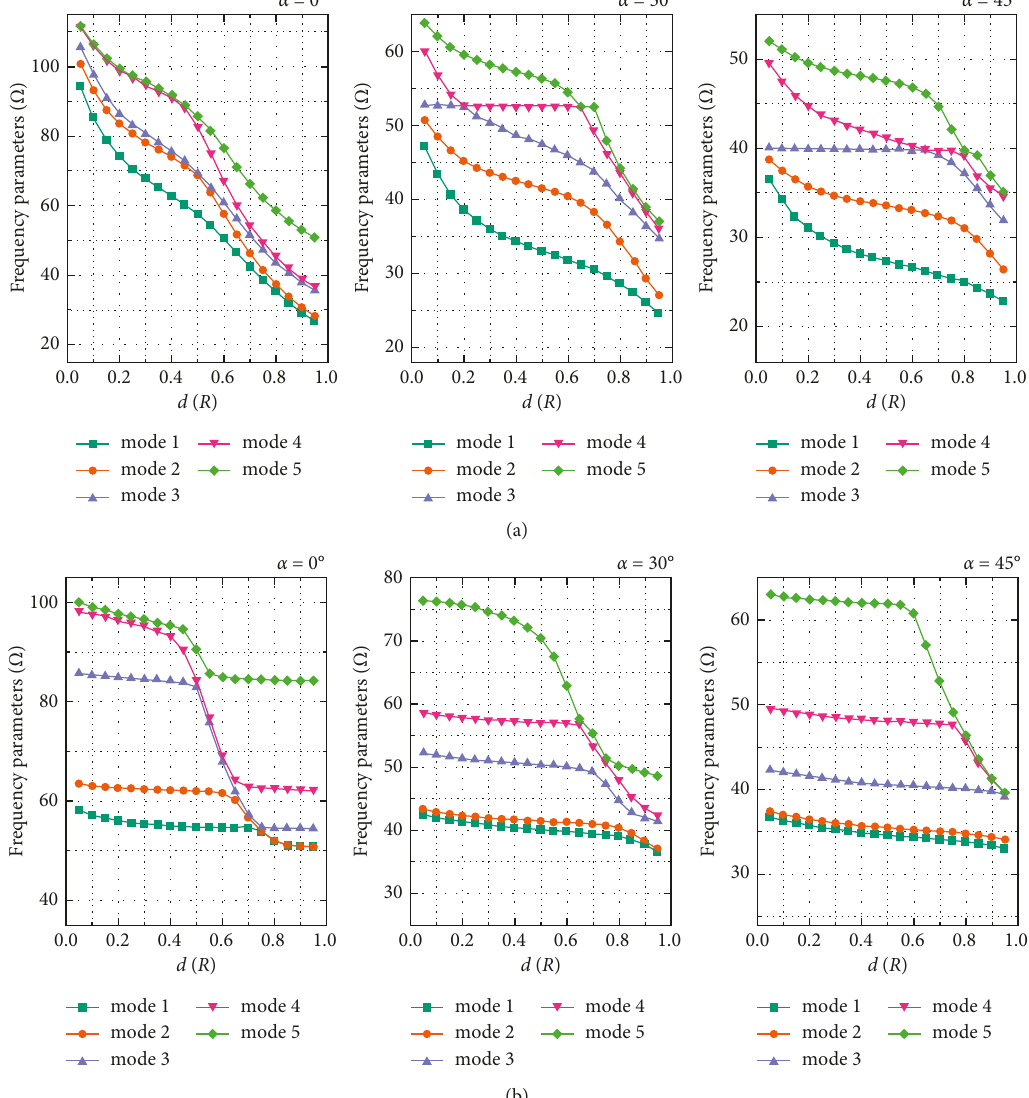
Figure 10: Variation of frequency parameters for FGOS with various heights of bulkheads: (a) FGM and (b) FGM II open shell with two circumferential bulkheads.